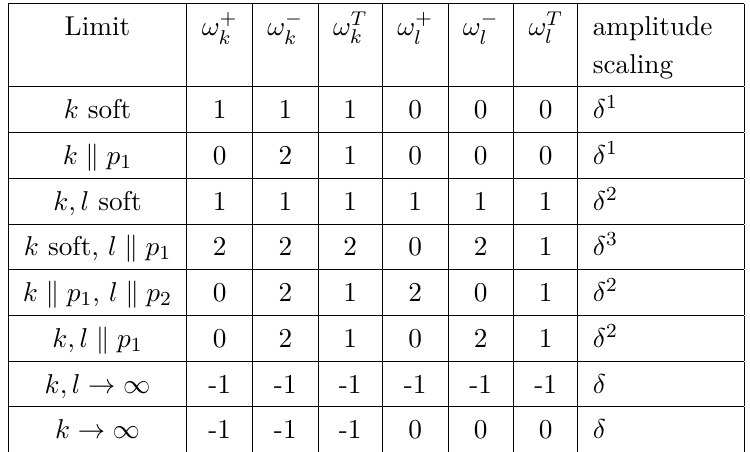
Table 1. The scaling behavior of the photonic contributions to the finite integrand f M (2) in various limits. The scaling of the integration measure has been taken into account, and the amplitude is convergent if it scales as any positive power of δ . The loop momenta k and l are parameterized as eq. (6.5), with the scaling exponents given in this table. Since the integrals always scale as δ raised to a positive power, there is no divergence in any of the IR / UV